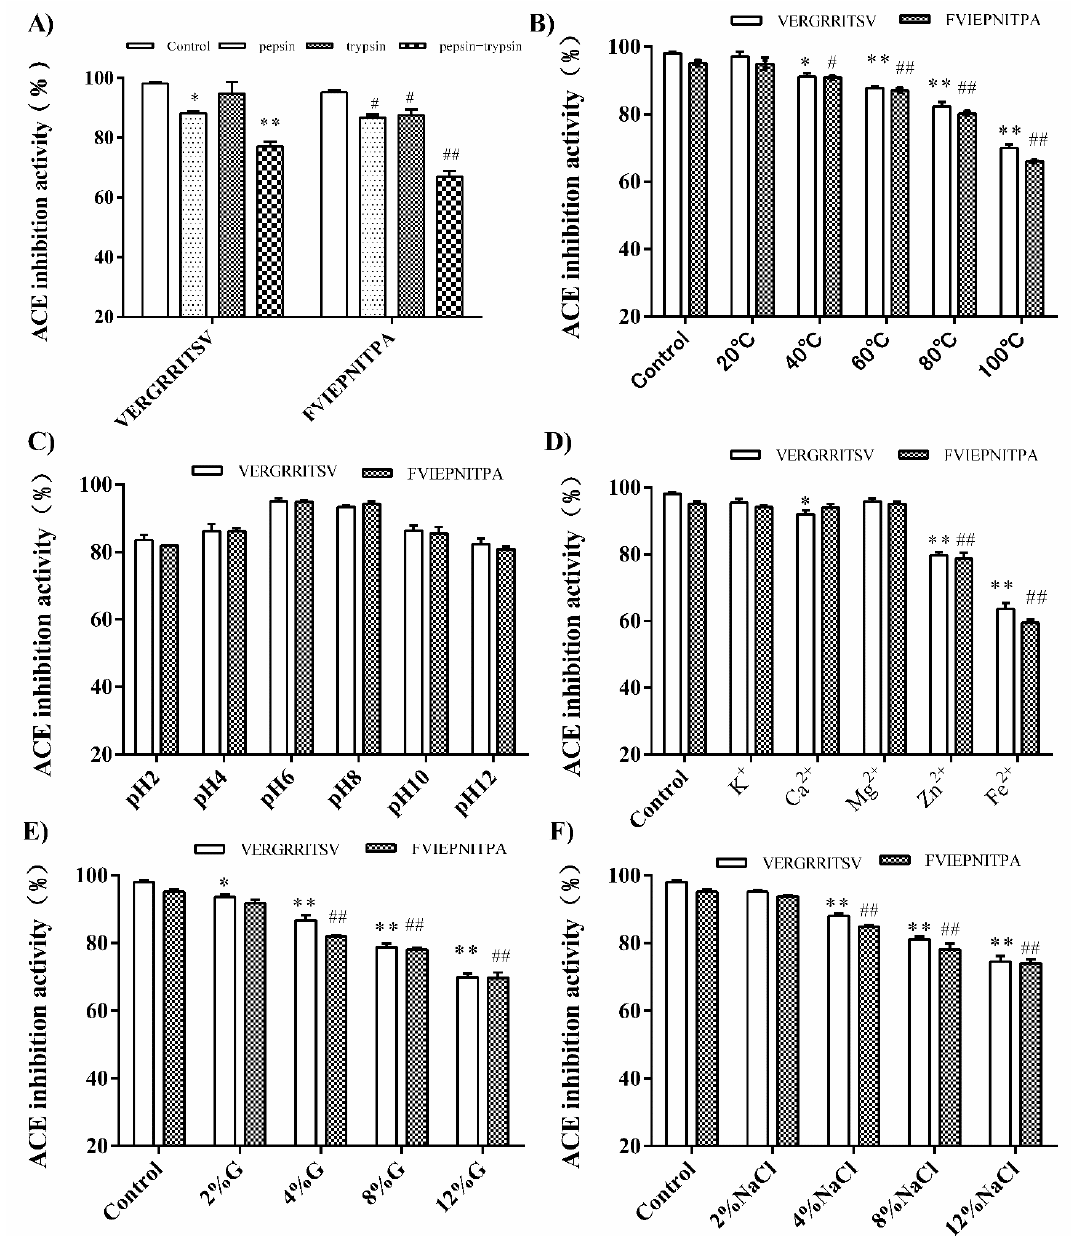
Figure 7. The stability of ACE-inhibitory activity in synthetic peptides VERGRRITSV and FVIEPNITPA exposed to sim ‐ ulated gastrointestinal digestion ( A ). Effect of temperature ( B ), pH ( C ), metal ions ( D ), glucose ( E ), and NaCl ( F ) on the